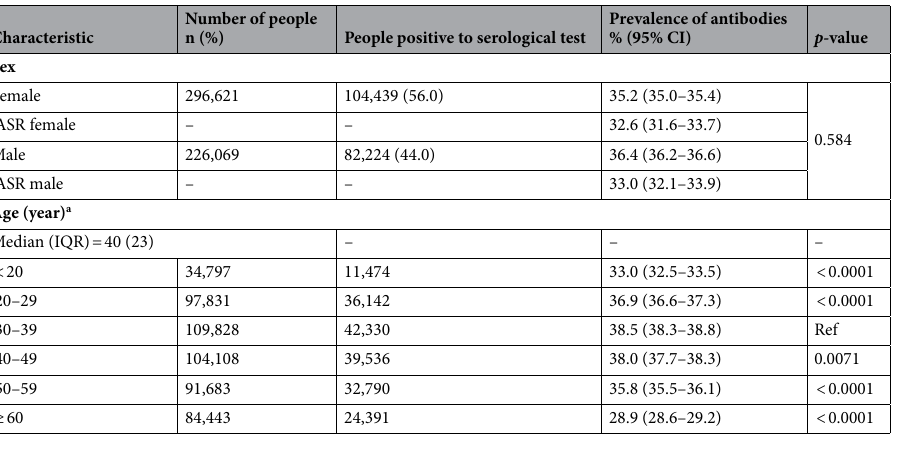
Table 1. Seroprevalence by age and sex of SARS-CoV-2 antibodies in 522,690 unvaccinated people. ASR = age and sex standardized rate per 100 inhabitants. IQR: interquartile range. ref = reference group. a p -values for x 2 test seroprevalence within